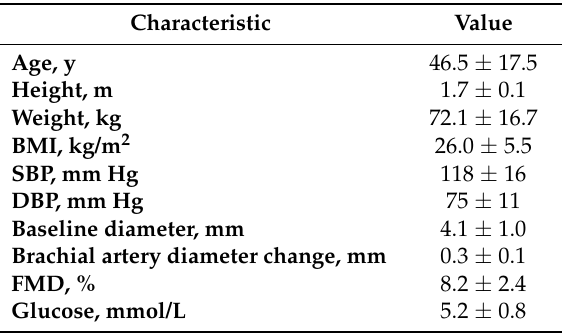
Table 1. Baseline characteristics of participants 1 .